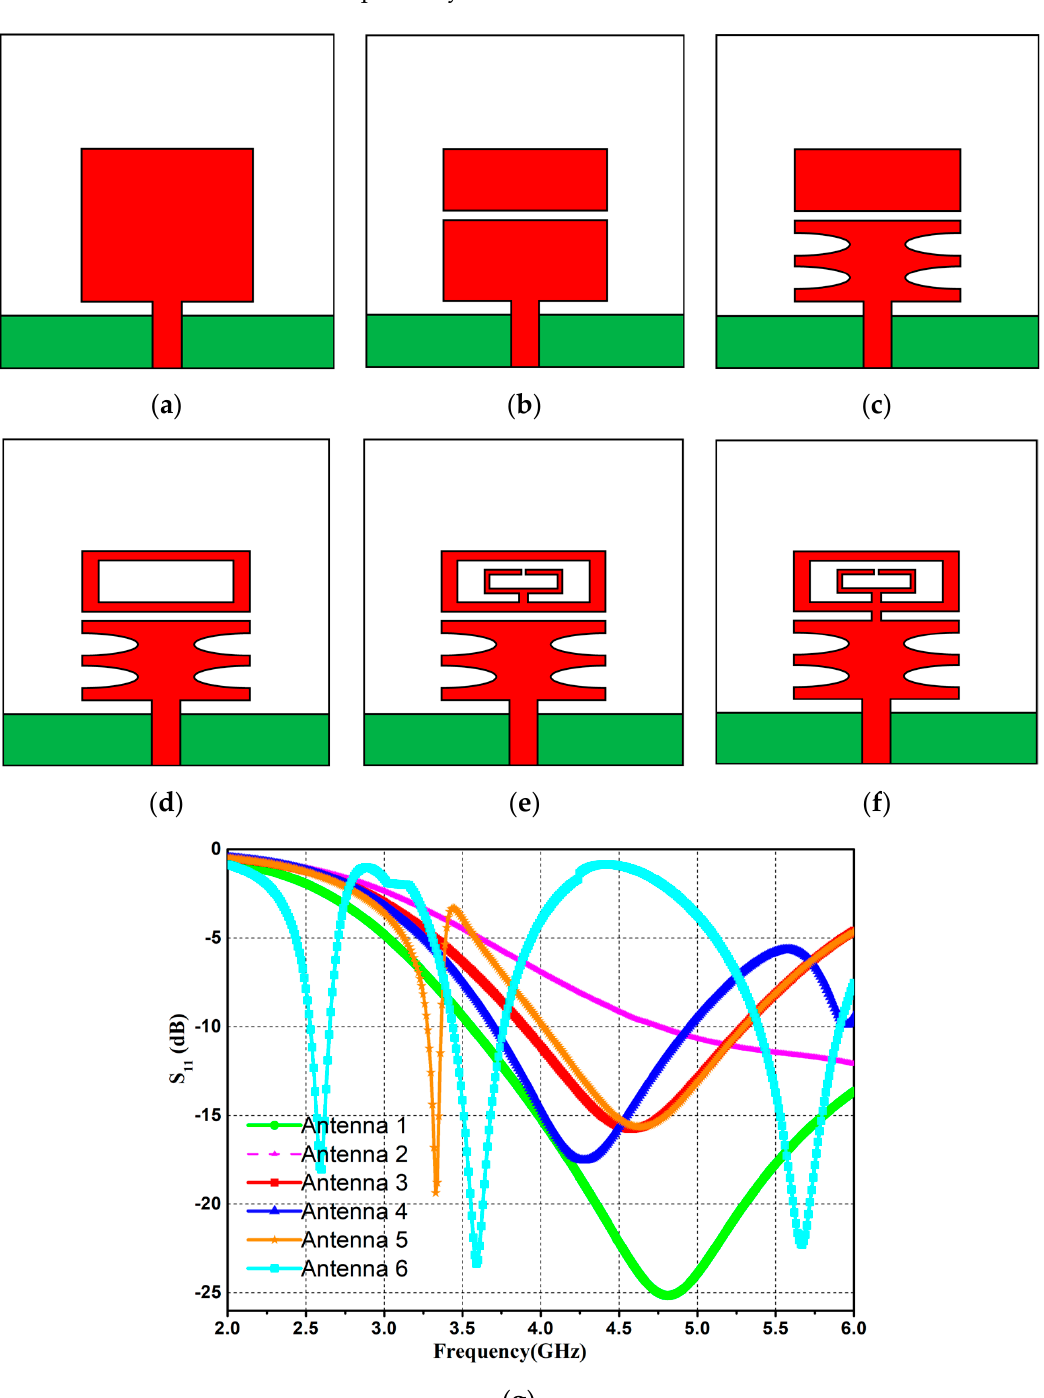
Figure 2. Development of the antenna element: ( a ) Antenna-1; ( b ) Antenna-2; ( c ) Antenna-3; ( d ) Antenna-4; ( e ) Antenna-5; ( f ) Antenna-6; ( g ) Scattering parameters of the design stages.